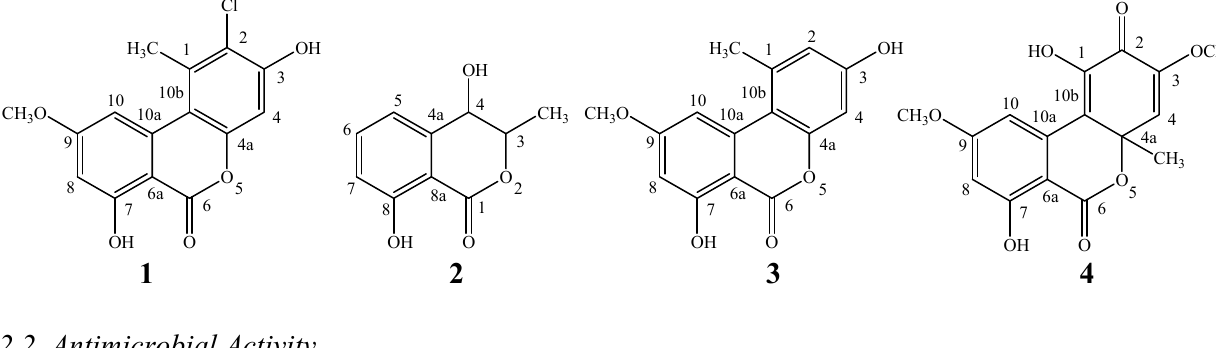
Table 1. Antimicrobial activity (IC